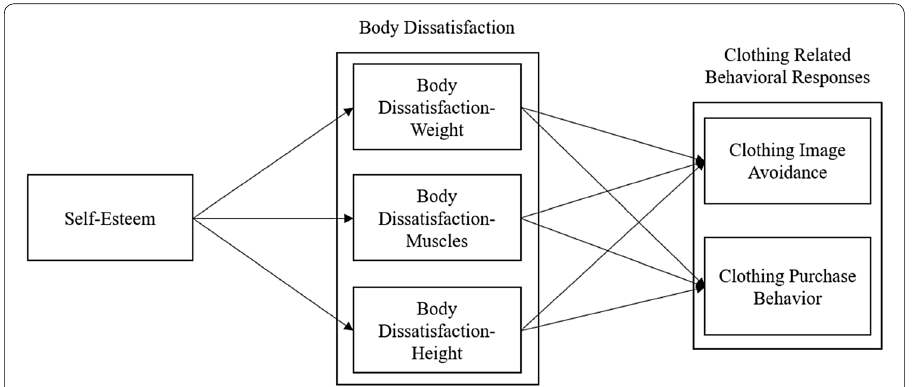
Fig. 1 Theoretical framework of the current